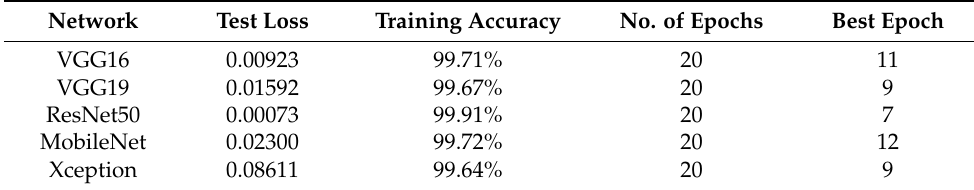
Table 2. Details and training accuracy of networks.